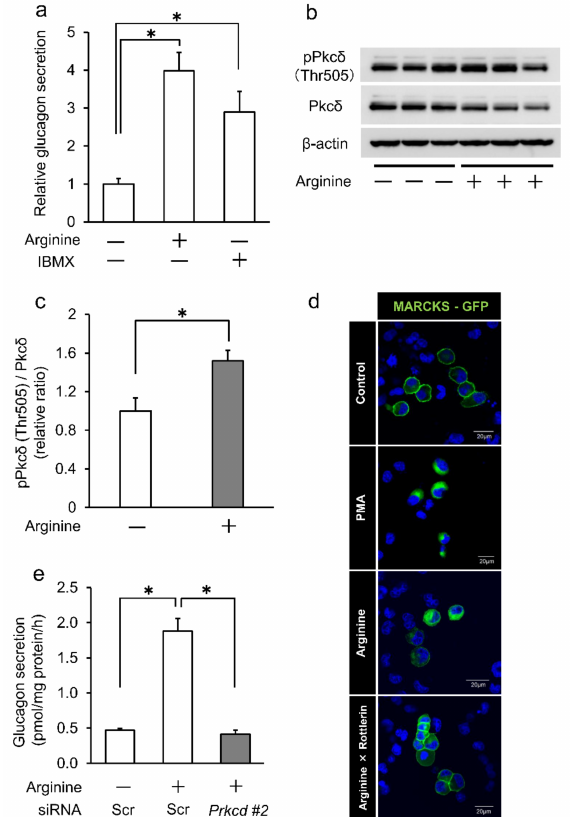
Figure 2. Arginine-induced glucagon secretion was decreased by Pkc δ knockdown in InR1G9 cells. ( a ) Glucagon secretion was significantly increased by 15-mM arginine and 100-mM IBMX in InR1G9 cells. ( b – c ) InR1G9 cells were treated with or without 15-mM arginine for 30 min; then cell lysates were examined for Pkc δ and pPkc δ (Thr505) by Western blotting. β -actin was employed as an internal control. Arginine significantly increased Pkc δ (Thr505)/Pkc δ relative ratio in InR1G9 cells. ( d ) InR1G9 cells were transfected with plasmid encoding MARCKS conjugated with GFP for 48 h followed by 100-mM PMA, 15-mM arginine, or 15-mM arginine plus 10- µ M rottlerin administration. MARCKS localized on the cell membrane was translocated to the cytoplasm by PMA. Arginine also translocated MARCKS to the cytoplasm, which was canceled by rottlerin. Representative photomicrographs are shown. Scale bars represent 20 µ m. ( e ) Arginine-induced glucagon secretion was significantly reduced by Prkcd #2 siRNA in InR1G9 cells. We performed triplicate and three independent experiments. * p < 0.05; t -test ( c ) or ANOVA (Bonferroni adjustment) ( a , e ). Data are expressed as means ±